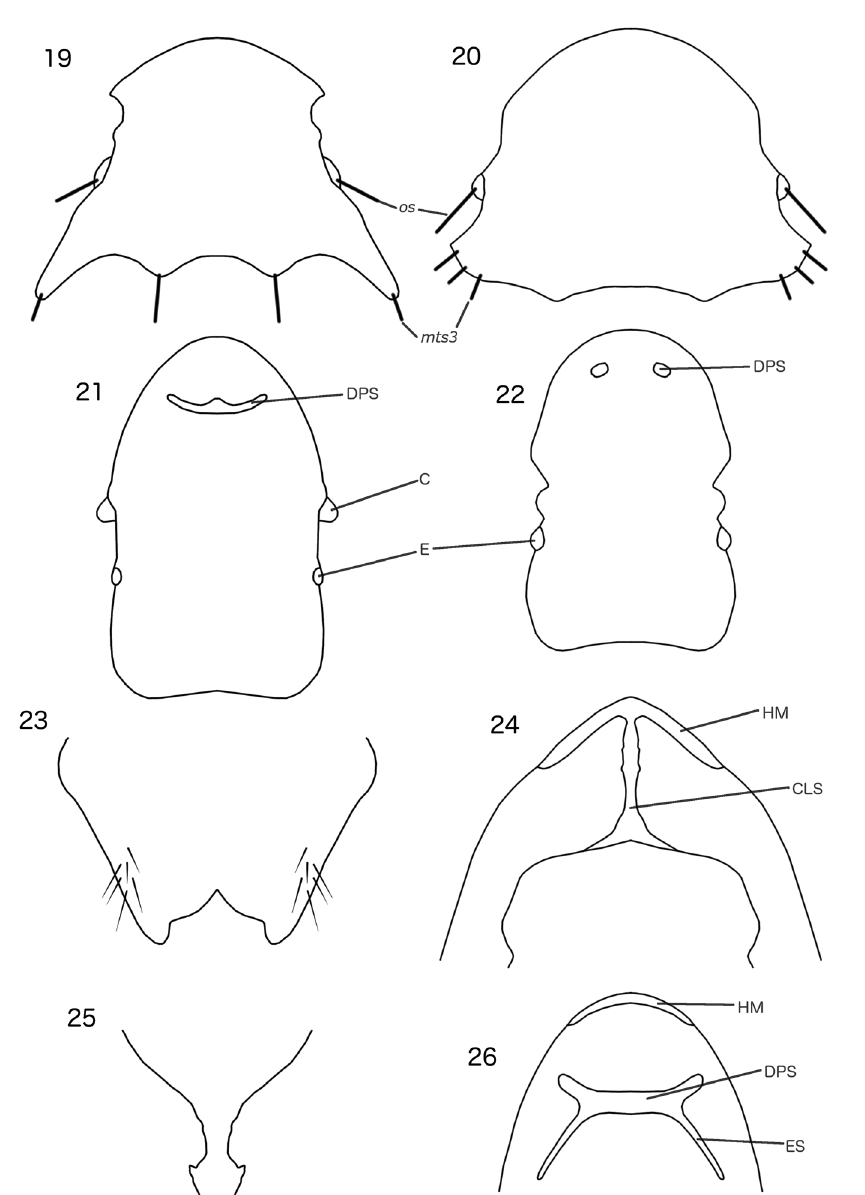
Figs 19–26. 19 . Outline of head and temporal macrosetae (cut off distally) of male Chelopistes meleagridis (Linnaeus, 1758), redrawn from Kéler (1939). 20 . Outline of head and temporal macrosetae (cut off distally) of female Trichodomedea setosus Carriker, 1946, redrawn from original description. 21 . Outline of head and dorsal preantennal suture of male Reticulipeurus mesopelios (Nitzsch, 1866), redrawn from Gustafsson et al . (2020). 22 . Outline of head and dorsal preantennal suture of male Cataphractomimus junae Gustafsson et al ., 2020, redrawn from original description. 23 . Female terminalia of Reticulipeurus mesopelios (Nitzsch, 1866), redrawn from Gustafsson et al . (2020); vulval margin, lateral macrosetae, and subvulval plates not illustrated. 24 . Ventral view of preantennal area in Gallancyra dentata (Sugimoto, 1934) (redrawn from Gustafsson & Zou 2020a). 25 . Outline of stylus in Gallancyra dentata (Sugimoto, 1934) (redrawn from Gustafsson & Zou 2020a). 26 . Outline of preantennal area and dorsal preantennal suture of Splendoroffula ampullaceal Kéler, 1955, redrawn from Kéler (1958). Antennae not included in any illustration. Abbreviations used: C = conus; CLS = clypeo-labral suture; DPS = dorsal preantennal suture; E = eye; ES = epistomal suture; HM = hyaline margin; mts3 = marginal temporal seta 3; os = ocular seta. Illustrations are not to